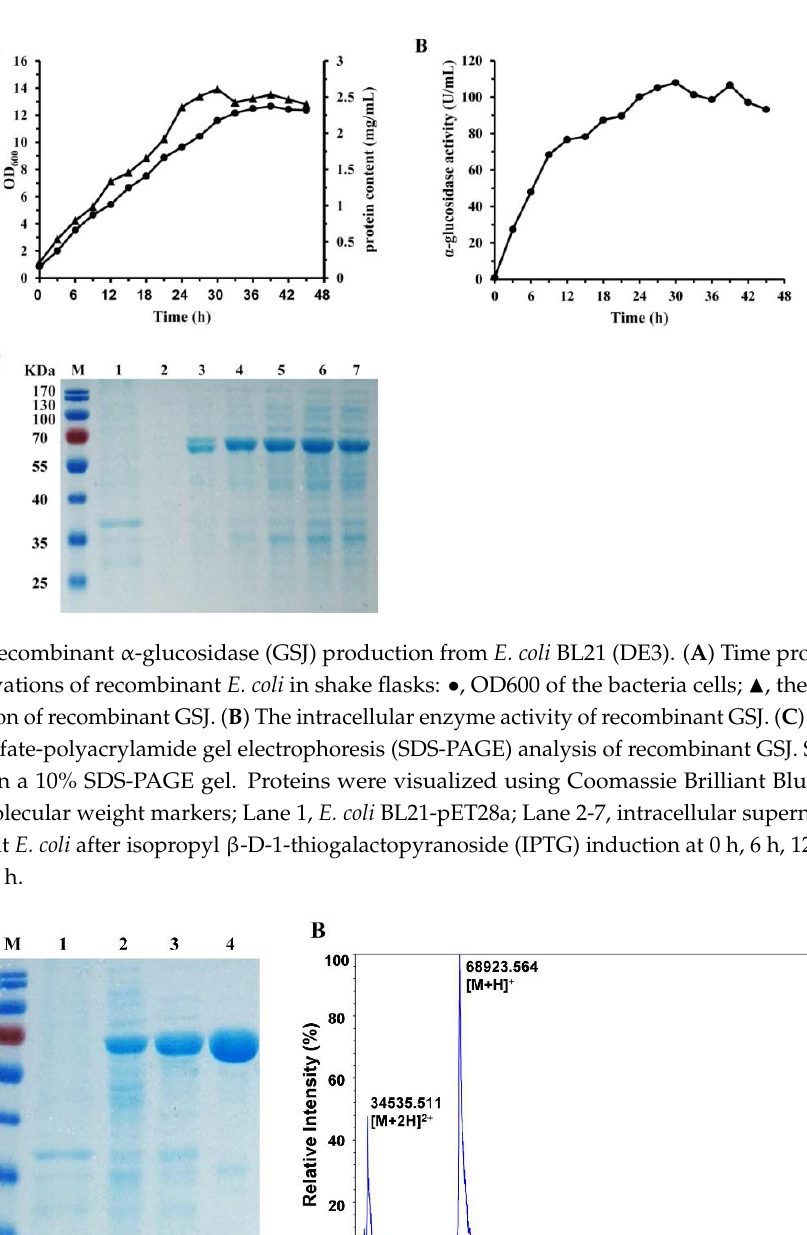
Table 1. Purification scheme of recombinant GSJ.